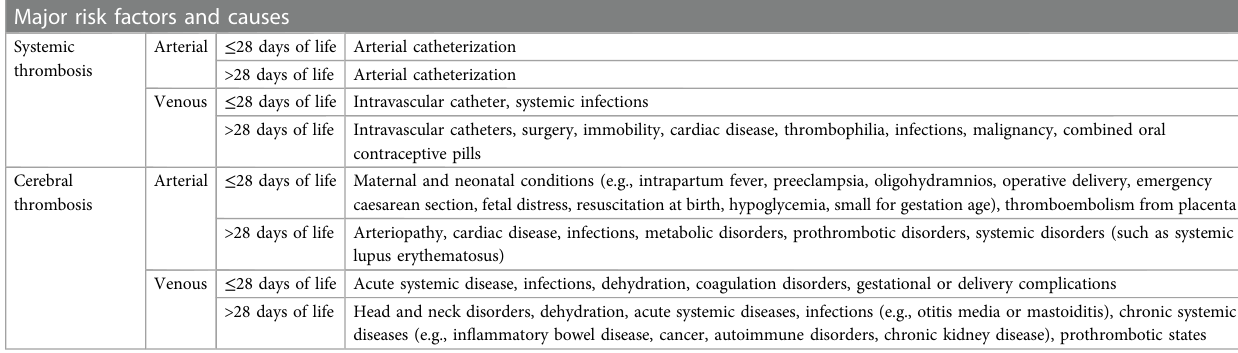
TABLE 2 Leading risk factors related to neonatal and pediatric thrombosis. Major risk factors and